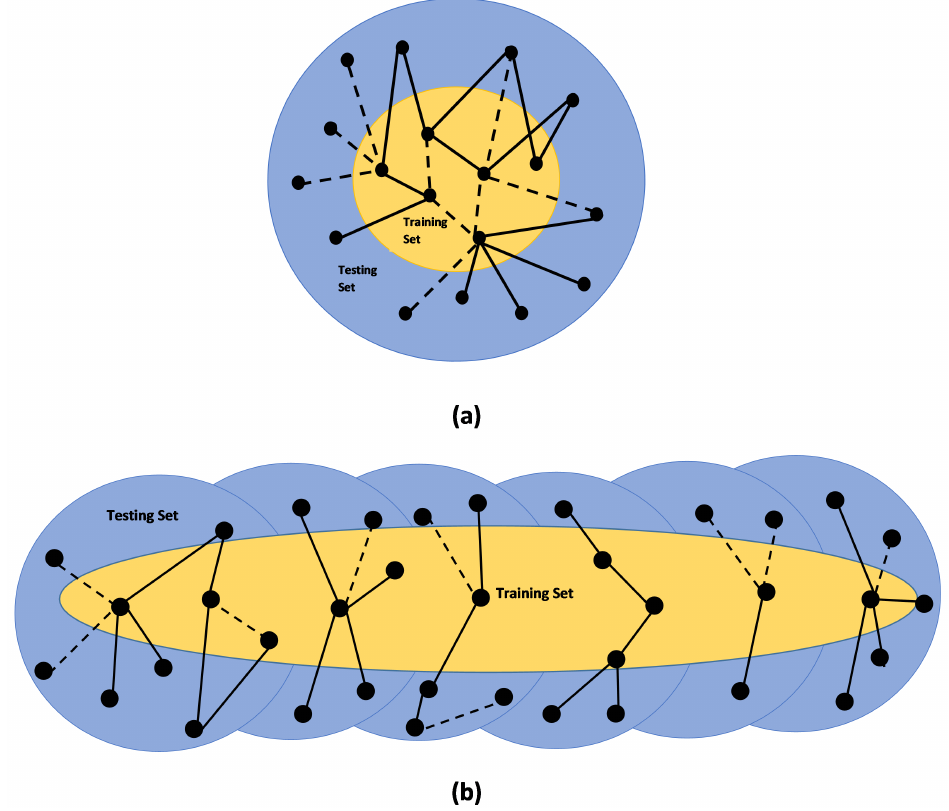
Figure 8. Train–test split for temporal graph as ( a ) single graph, ( b ) a sequence of single-layered